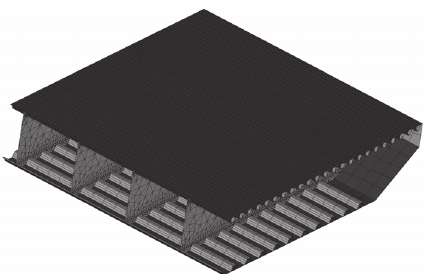
Figure 6: Finite element model of a half-segmental steel box-girder.